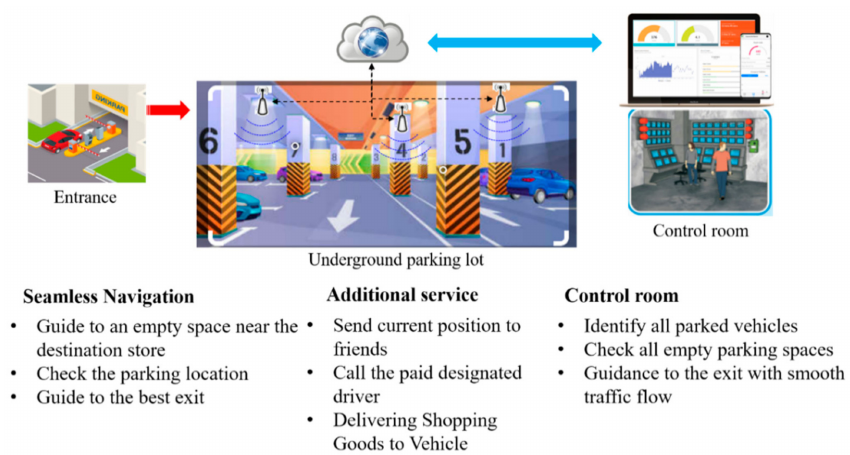
Figure 2. Overall proposed system configuration and its